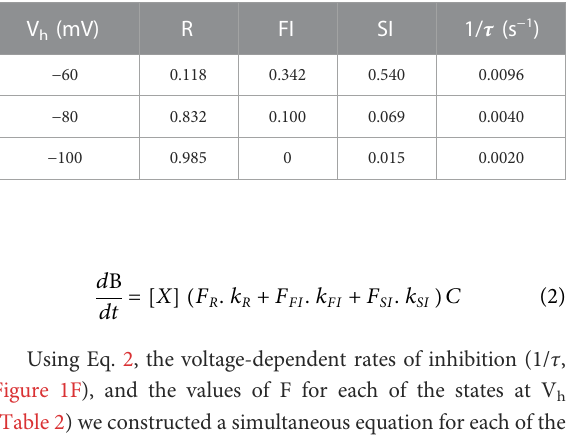
TABLE 2 Parameters used in